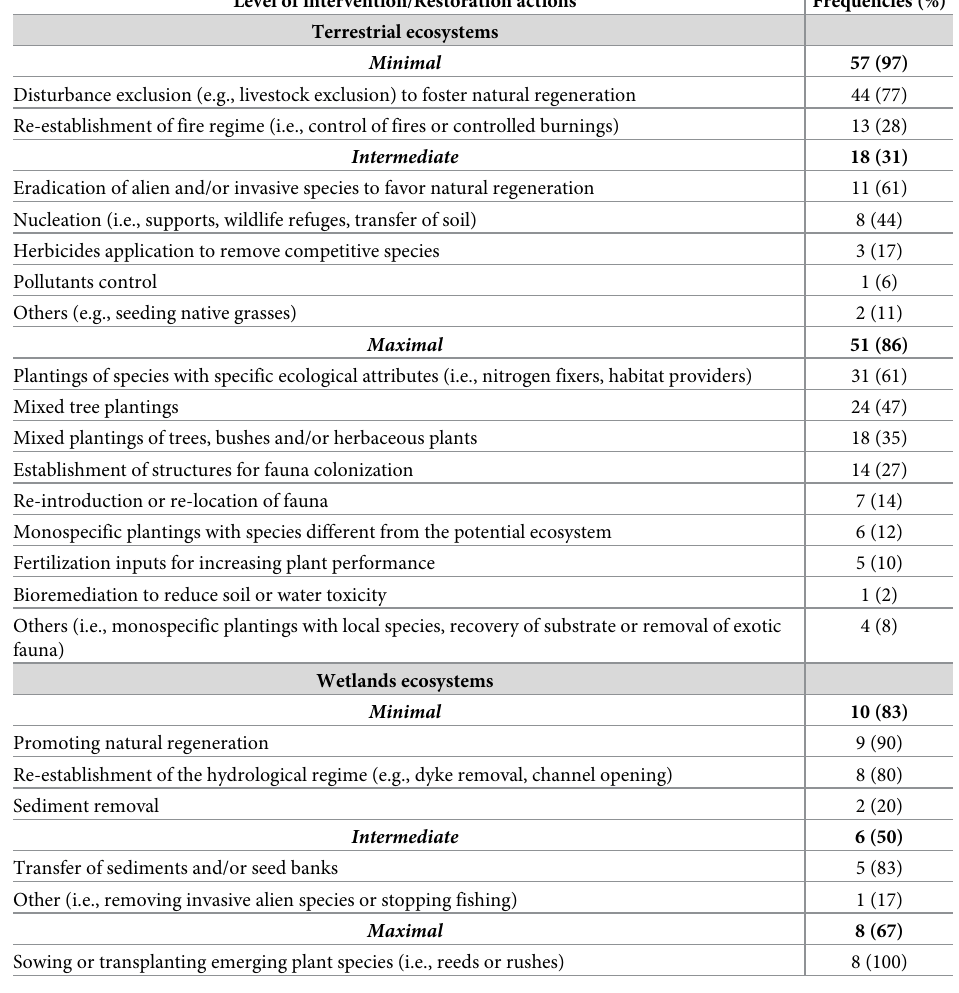
mented intervention (Table 1). Ninety percent of projects included promoting natural Table 1. The frequency (percentage) of actions included in the restoration projects classified as minimal, interme- diate, or +maximal intervention level. Level of intervention/Restoration actions Frequencies (%) Terrestrial ecosystems Minimal 57 (97) Disturbance exclusion (e.g., livestock exclusion) to foster natural regeneration 44 (77) Re-establishment of fire regime (i.e., control of fires or controlled burnings) 13 (28) Intermediate 18 (31) 11 (61) 8 (44)